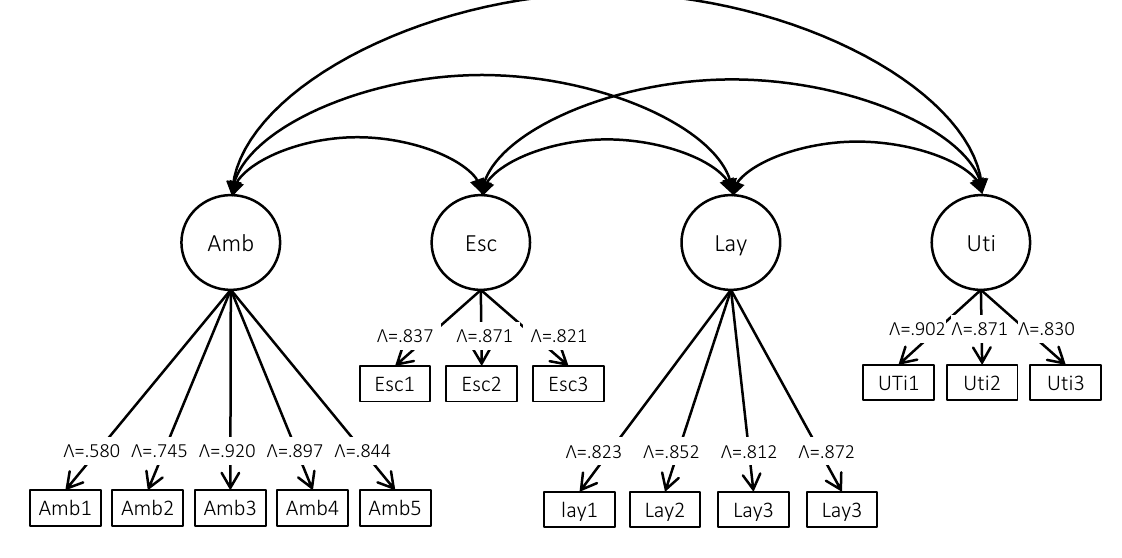
Figure 2. Measurement